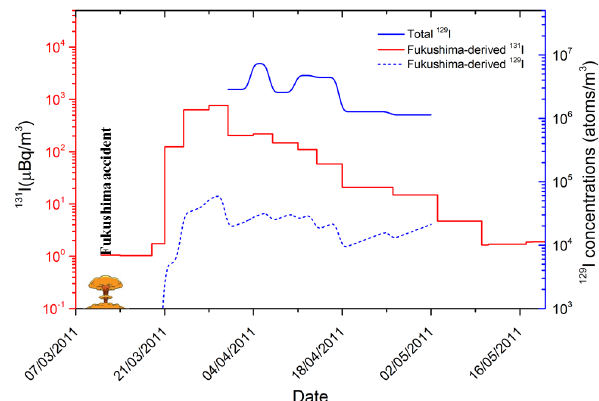
Figure 7. 131 I radioactivity (red, Nielsen et al., 2011), 129 I concen- trations (blue) in aerosols from Risø, Denmark after the Fukushima accident. The Fukushima-derived 129 I concentrations are calcu- lated based on 129 I / 131 I atomic ratio of 16.0 ± 2.2 deduced from Fukushima-affected aerosol samples (Xu et al.,